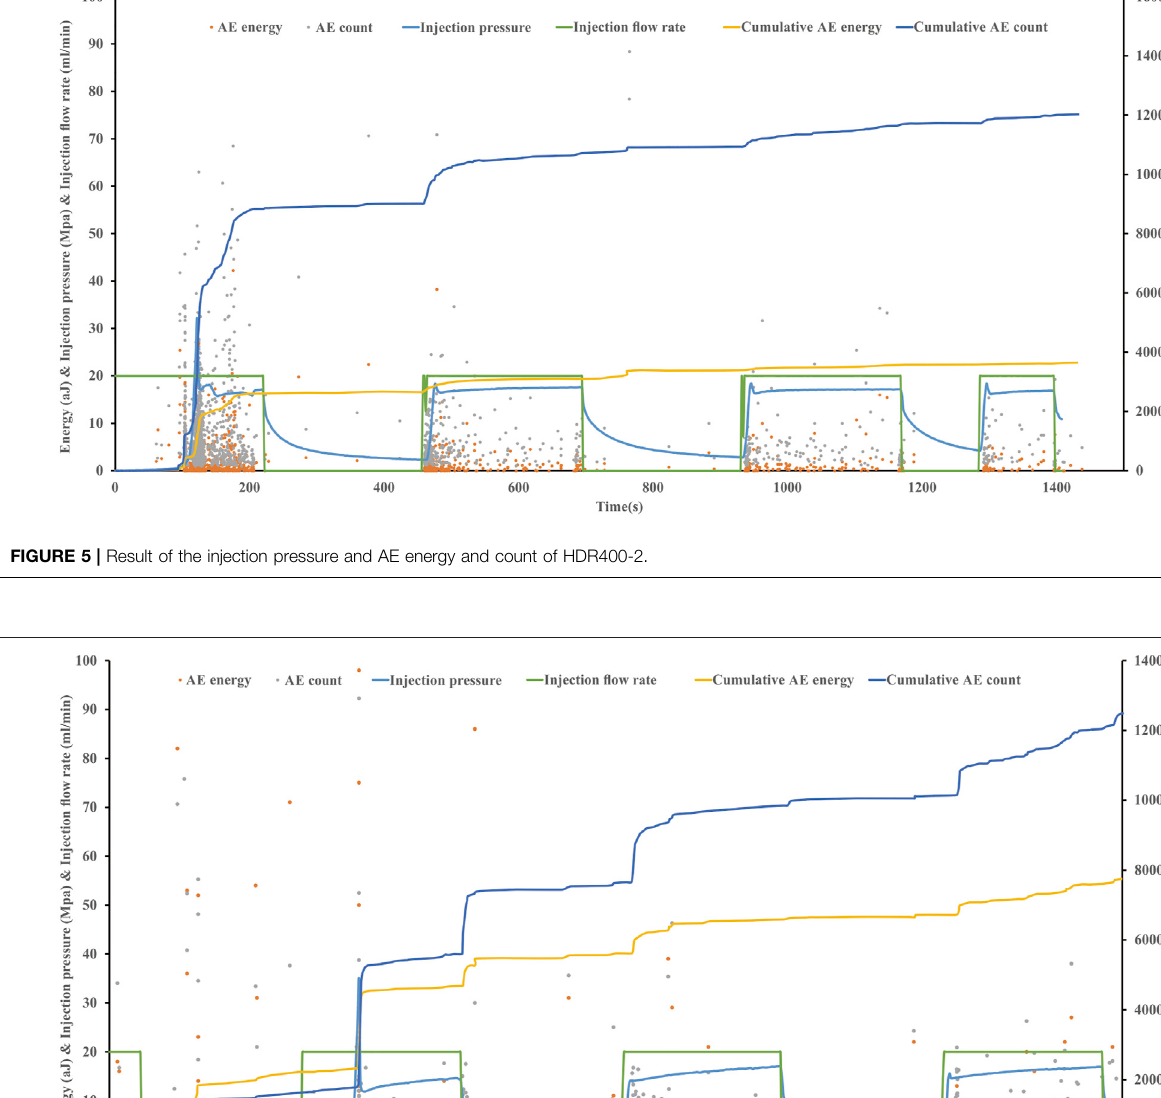
Frontiers in Earth Science |